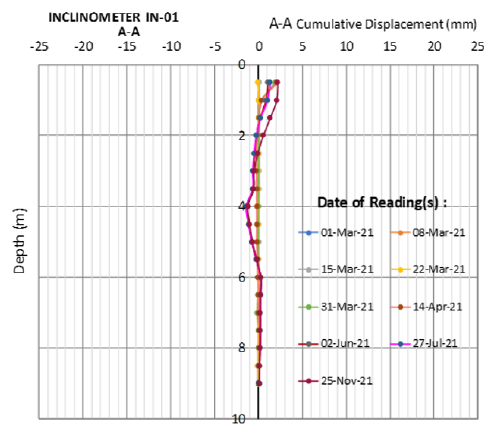
Figure 12. Location of the inclinometer in Cimanggung slope failure.